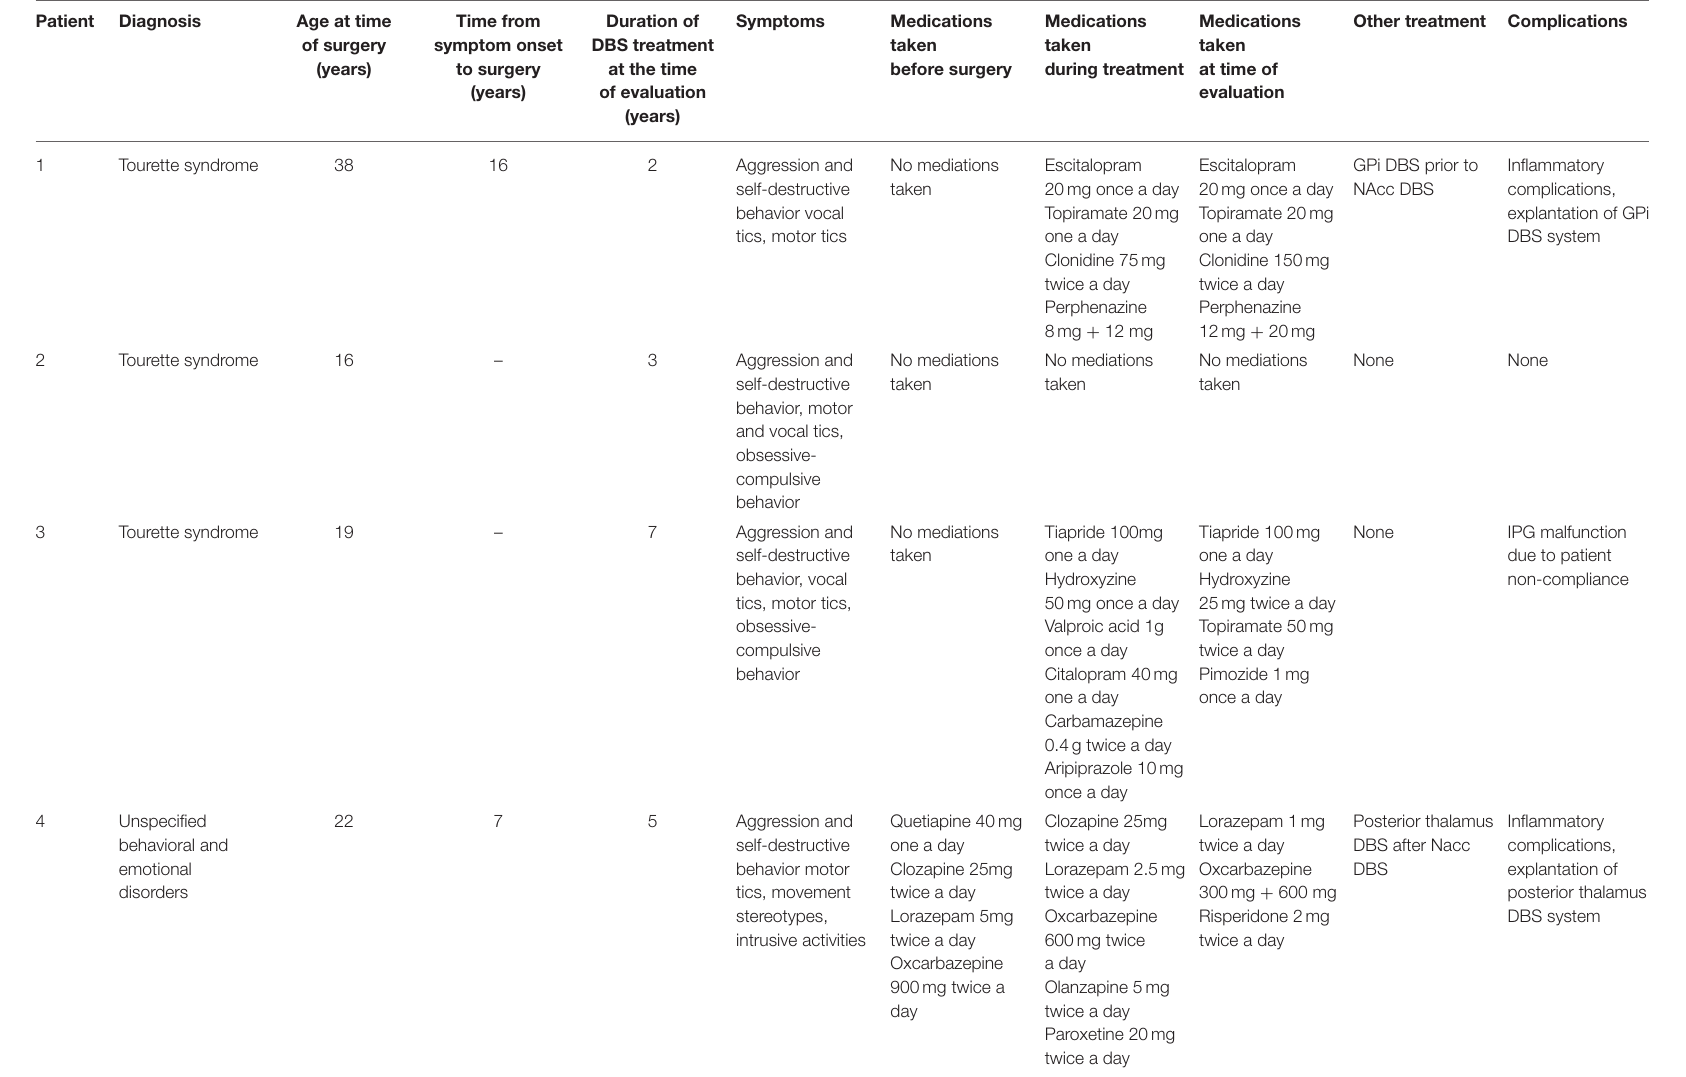
TABLE 1 | The clinical and follow-up details of the case